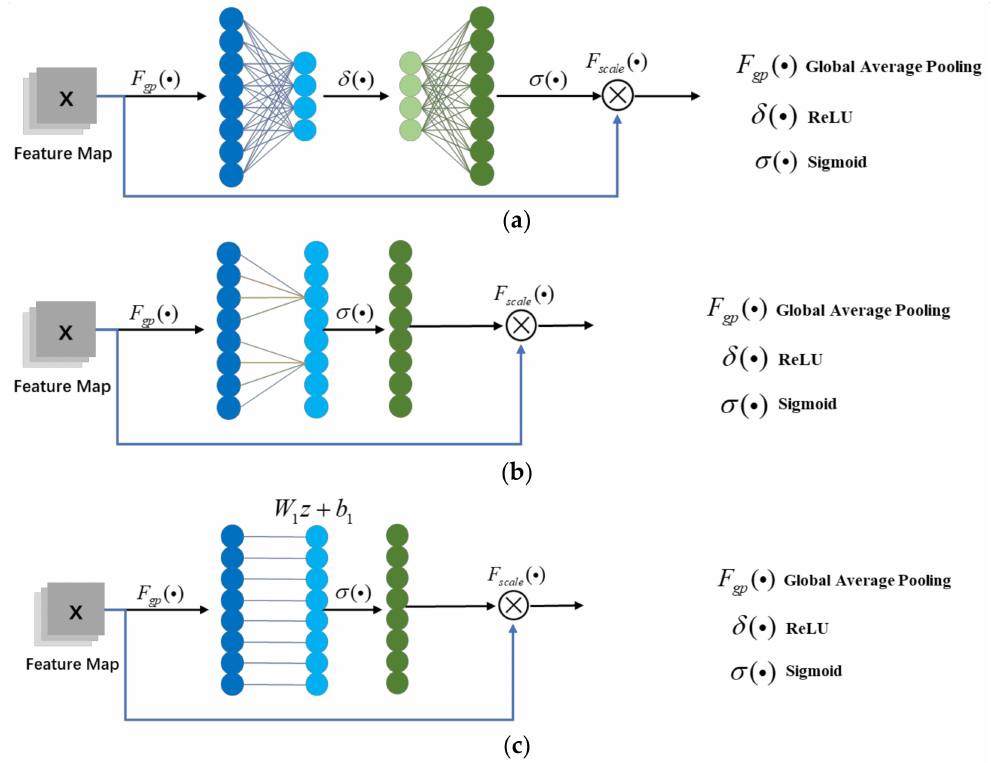
Figure 4. The structure of different channel attention. ( a ) The structure of SE-Net; ( b ) the structure of ECA-Net; ( c ) the structure of shuffle attention